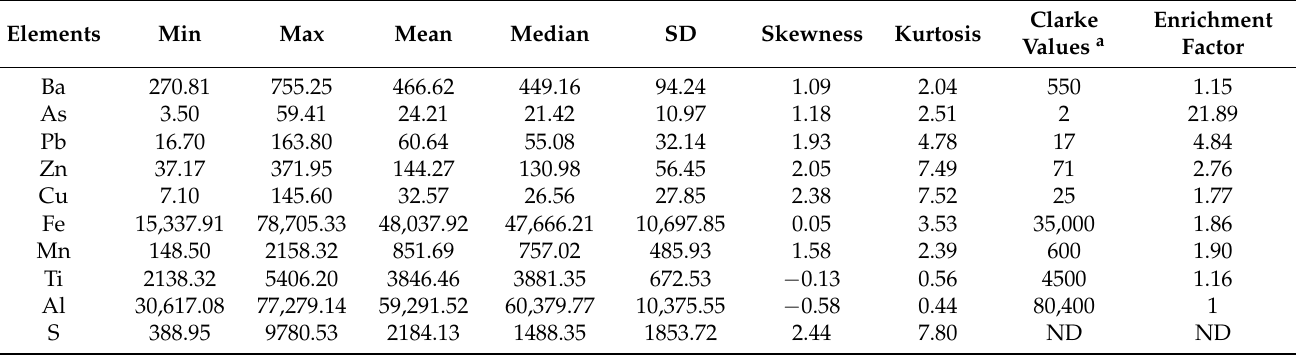
Table 2. Descriptive statistics: Clarke values and enrichment factors (compared to the upper conti- nental crust) of the chemical elements of the examined Jerada soils (34